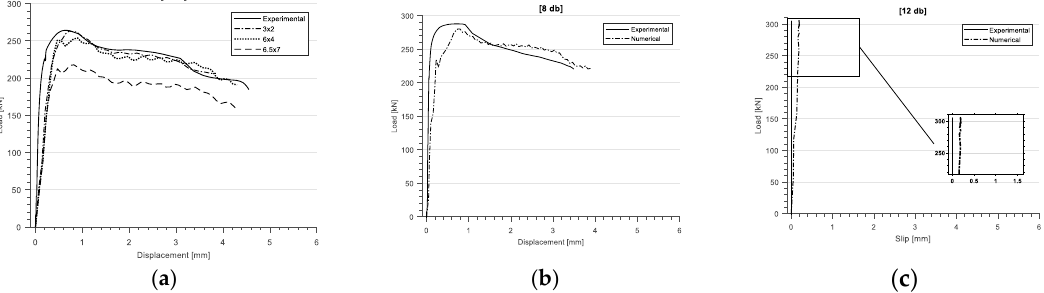
Figure 8. ( a ) Finite element (FE) model parts, elements, and boundary conditions after Elsayed and Nehdi [3]; ( b ) bond plastification progression; ( c ) interfacial element deletion to simulate shearing of the grout keys.